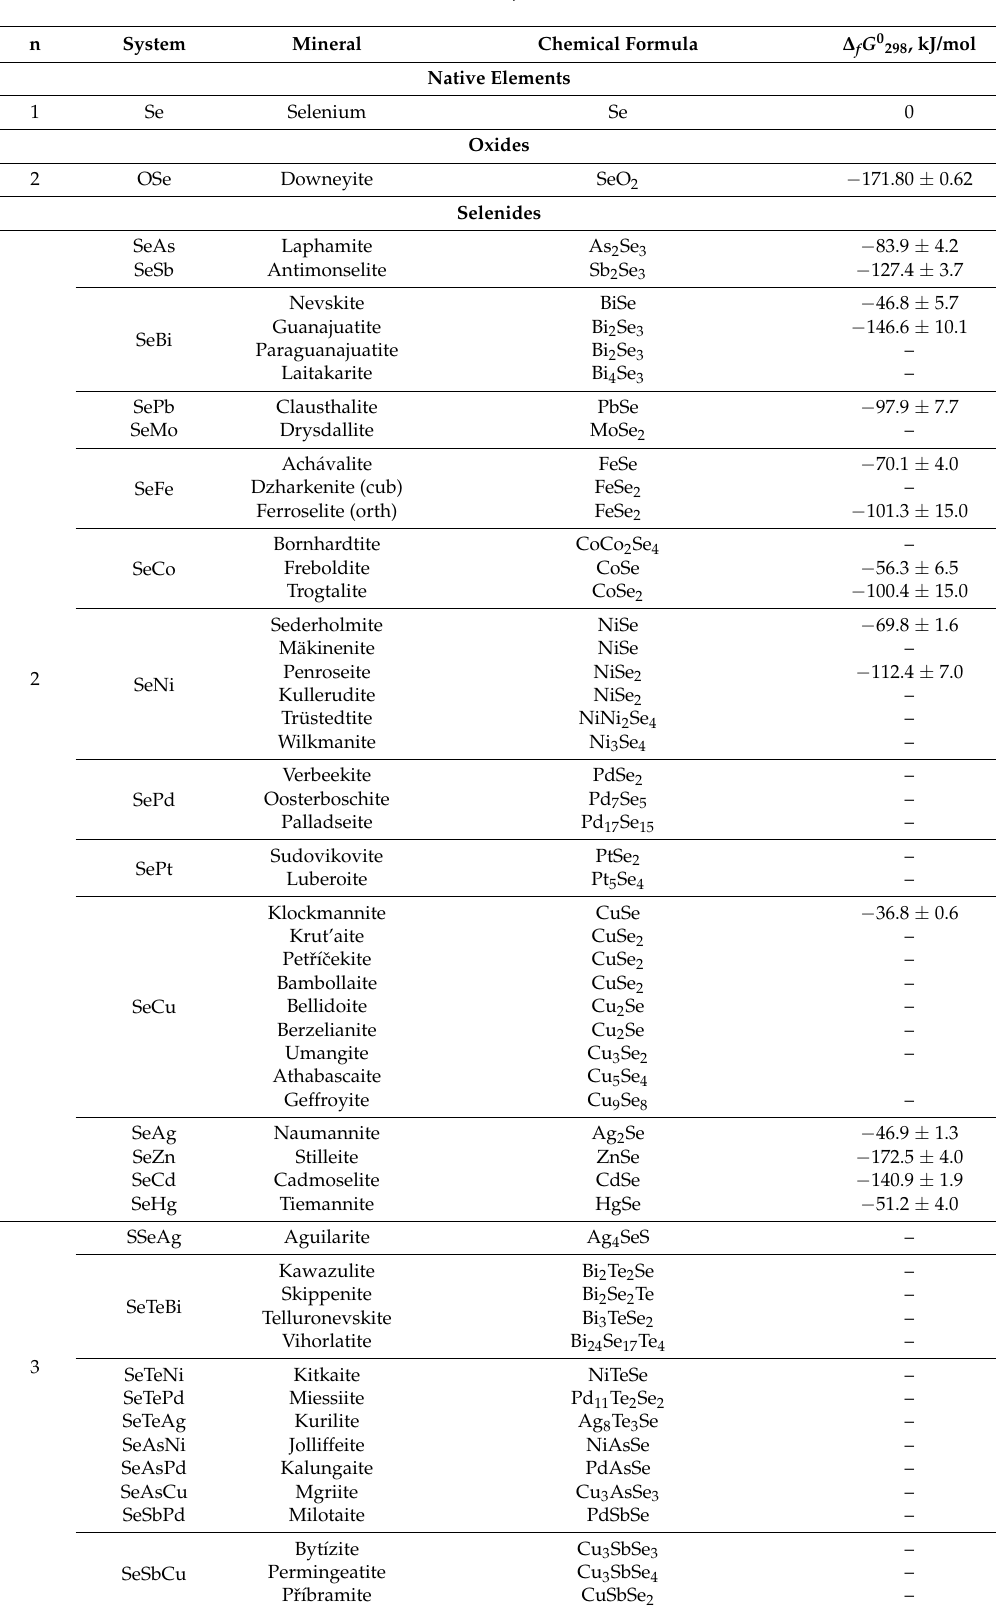
Table 1. Mineral systems and ∆ f G 0 298 of selenium